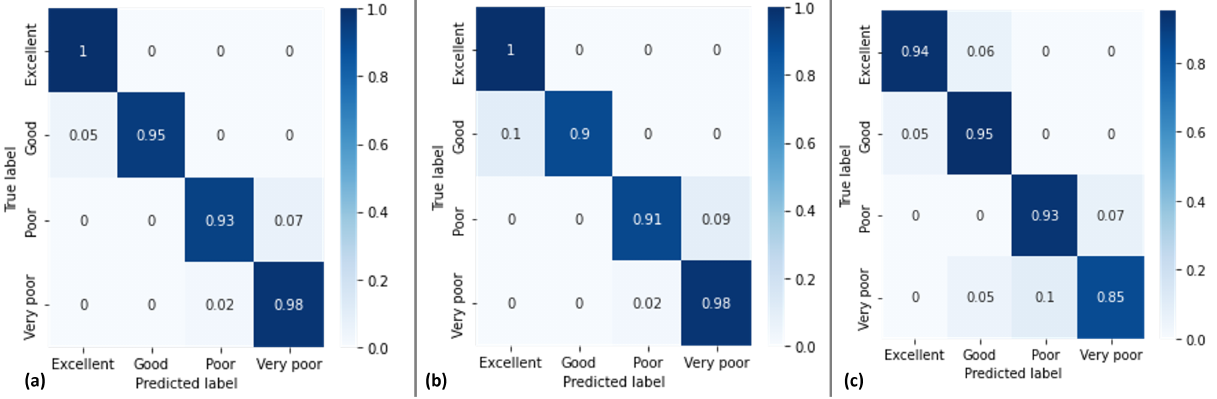
Figure 11. Normalized confusion matrices for the water zones’ classification without embedding using: ( a ) SVM, ( b ) LR, ( c )